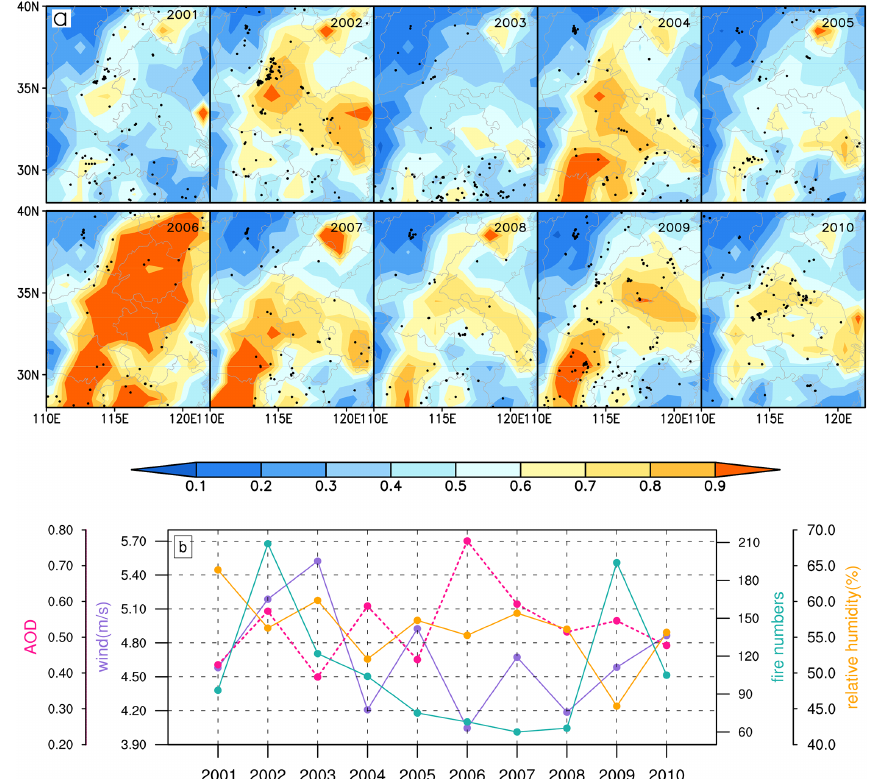
Figure 2. (a) The distribution of AOD over eastern China in October for 2001–2010. The black dots are fire locations. (b) Interannual variability of column AOD (peach). The number of fires is in green. Wind speed (purple) and relative humidity (orange) are averages in the lower troposphere (1000–850hPa) and over the region shown in (a)